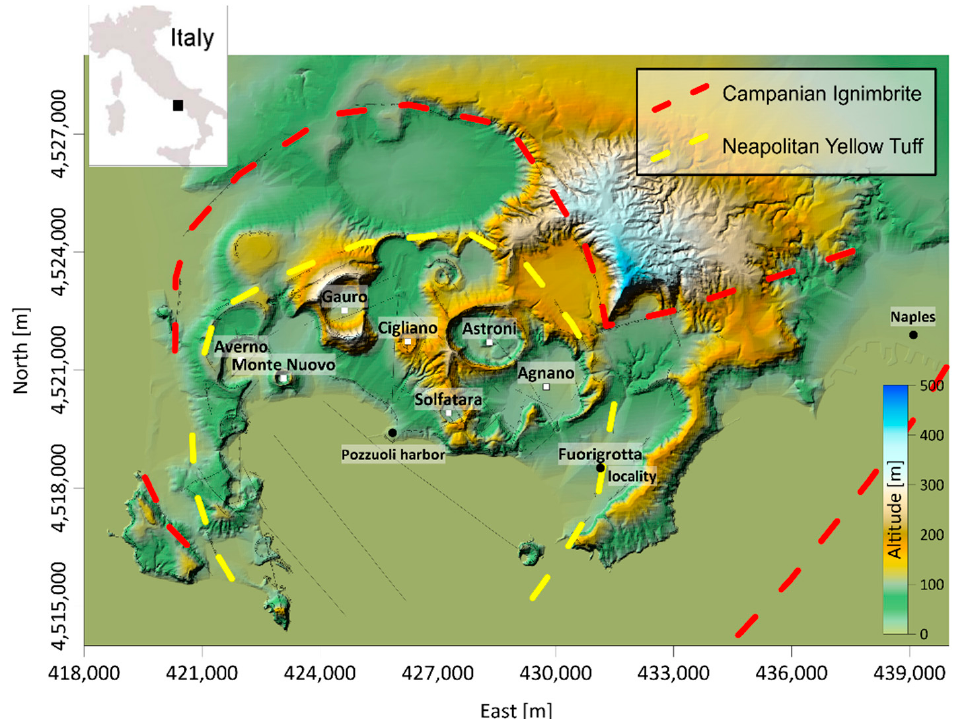
Figure 1. Campi Flegrei caldera. SRTM DEM of the area with red and yellow dotted lines indicating the Campanian Ignimbrite (CI) and Neapolitan Yellow Tuff (NYT) caldera borders, respectively (modified or adapted from [18]). The black lines show the faults and outer/inner rims [19]. The white squares indicate the locations of the caldera main eruptive centers. The UTM-WGS84 projection zone is 33 N.